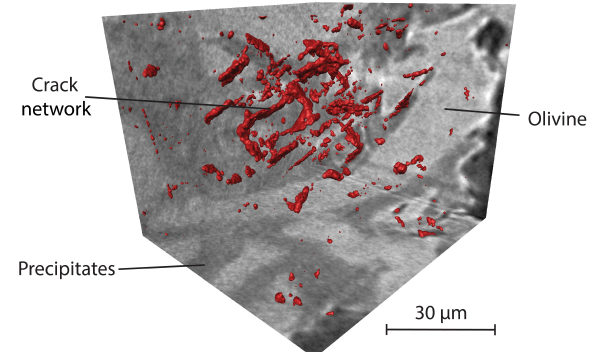
Figure 12. Network of microcracks (red) in the reaction olivine cup wall from SGC shows a polygonal pattern. The dissolution channels make the grain (light grey) more susceptible and a stress concentra- tion is also likely to occur around the etch